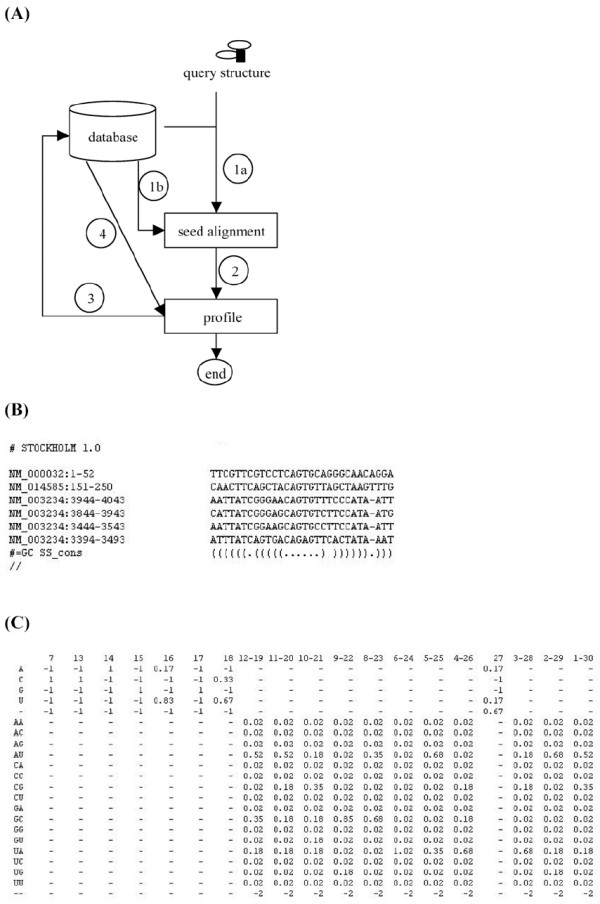
Multiple structure alignment and iterative database search. (A) Flowchart of multiple structure alignment and iterative database search. Step (1a) accepts a query structure to start an iterative database search; step (1b) processes a small database for multiple structure alignment; step (2) derives a profile from the seed alignment; step (3) uses the profile to conduct search; and step (4) updates the profile with new alignment. (B) Multiple structure alignment of several IRE structures. (C) PSSM of the multiple alignment of IRE in (B). Each column in the PSSM corresponds to the position of a structure component, either single base or base pair. Position of a single base is represented by the nucleotide number and position of a base pair is represented by two nucleotide numbers connected by a dash. For each column, the scores of individual structure components in that position are listed in rows where "-" means not applicable.